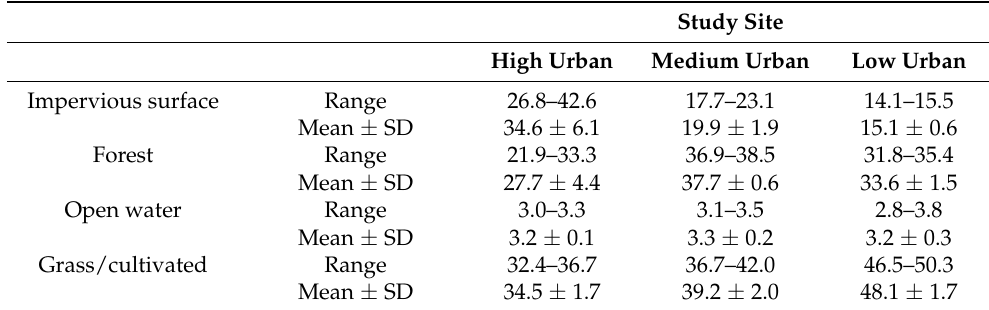
Table 1. The percentages of impervious surface, forest, open water, and grass/cultivated land within a 5 km 2 buffer at six raptor survey locations in three survey sites within the Great Trinity Forest, Dallas, TX, USA.